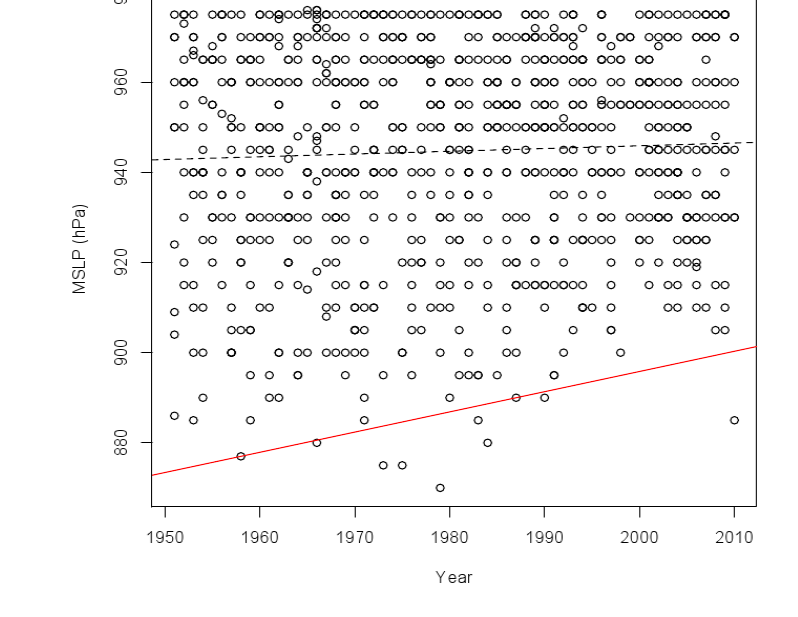
Table 1. Summary statistics for quantile regression 1951–2010.